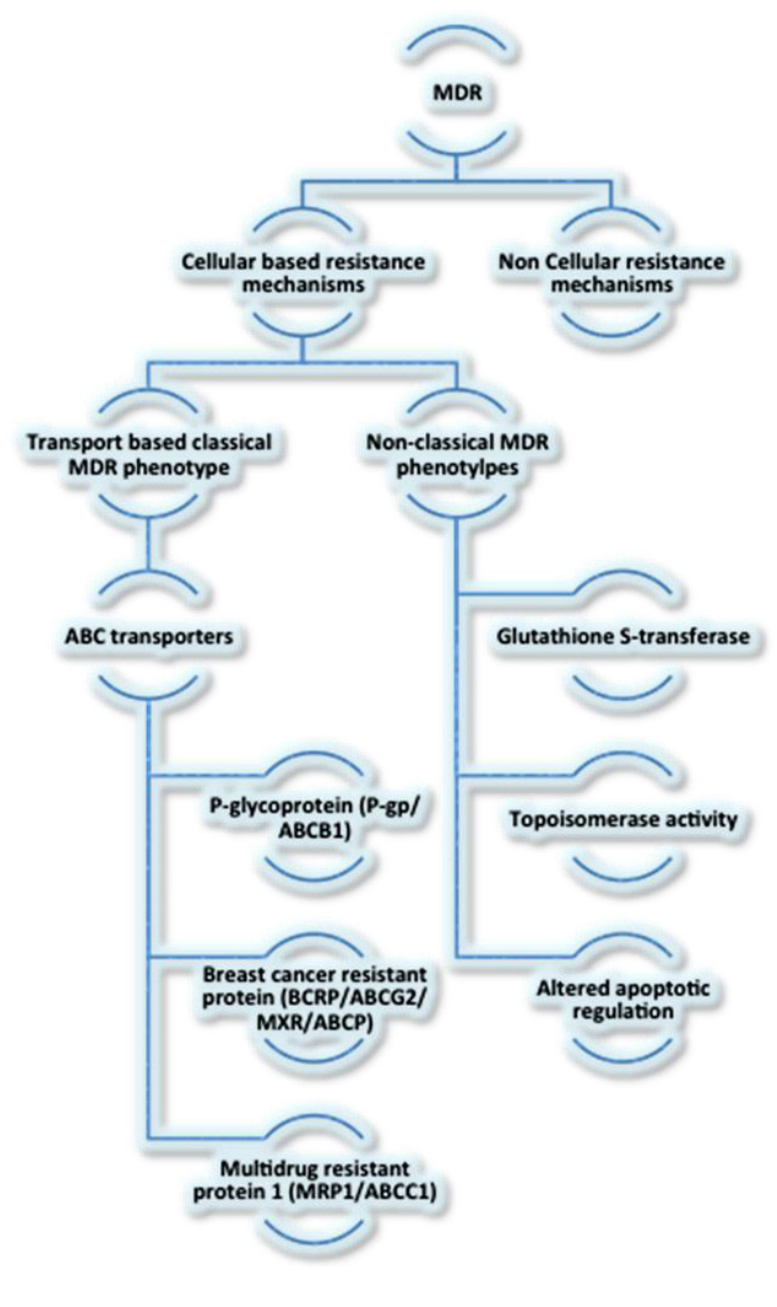
Figure 1. Classification of MDR. A flowchart illustrating the classification of